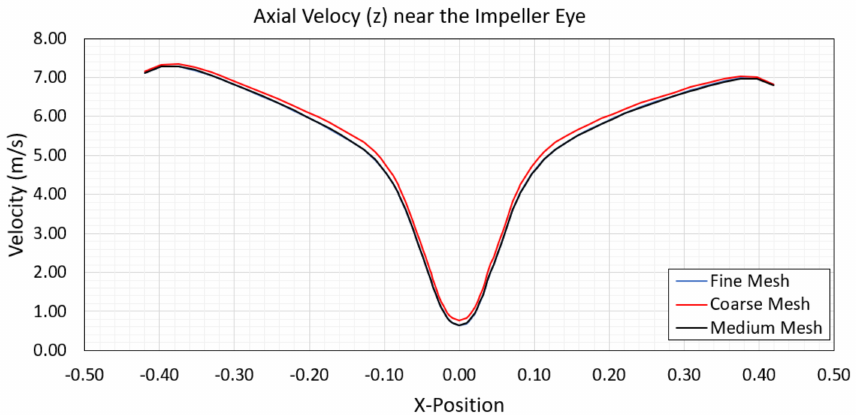
Figure 5. The axial velocity distribution near the impeller eye at 90% rated capacity.